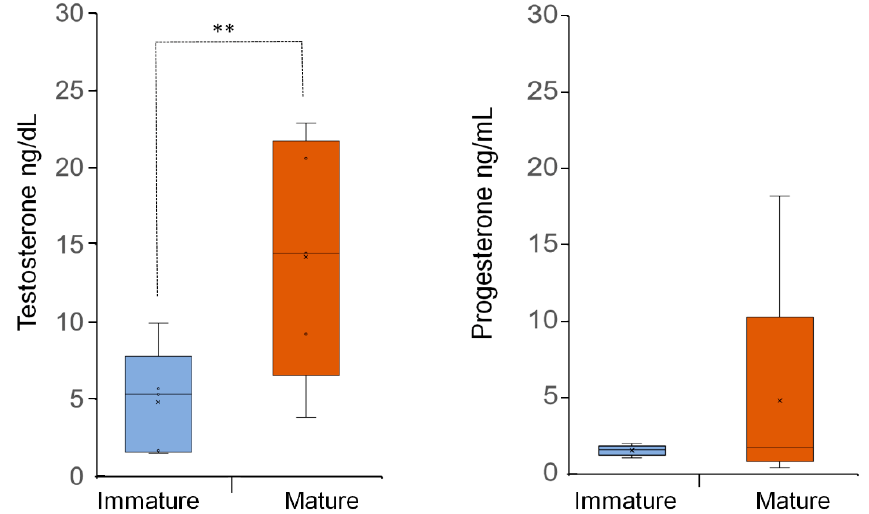
Figure 4. Distribution of mature and immature S. coeruleoalba striped dolphins according to sex hormones. Testosterone and progesterone levels were measured in blood obtained from dolphins at the time of stranding. Two female dolphins with progesterone levels >12 ng/mL were pregnant at the time of stranding (CR08-06 and CR04-12). Asterisk denotes a p < 0.005, top circle and bottom circle denotes quartile 3 and 1 respectively, X denotes mean.